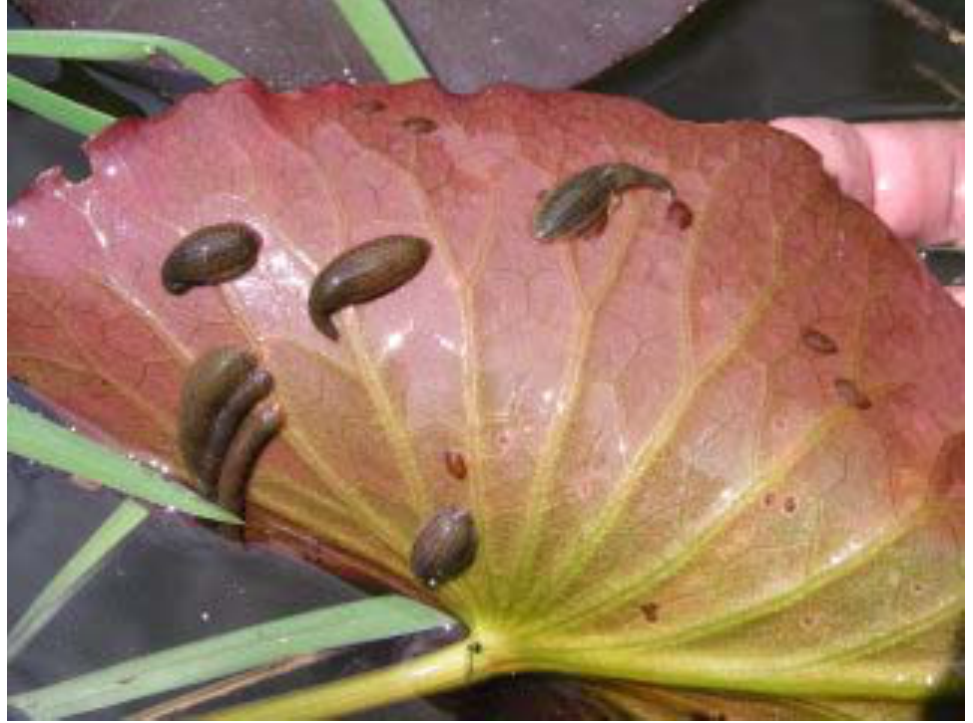
Figure 2. The main used bioindicator species - Erpobdella